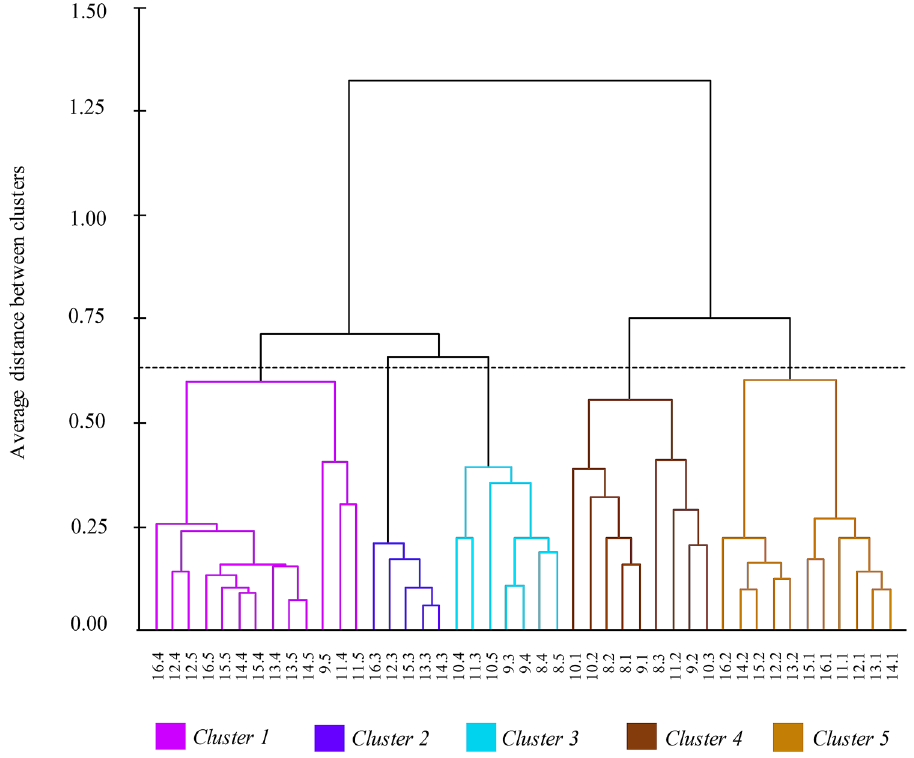
Figure 7. Dendrogram illustrating the groups formed by the cluster analysis using blade segments of leaves with contrasting levels of insertion on the tiller axis (phytomers) of Napier elephant